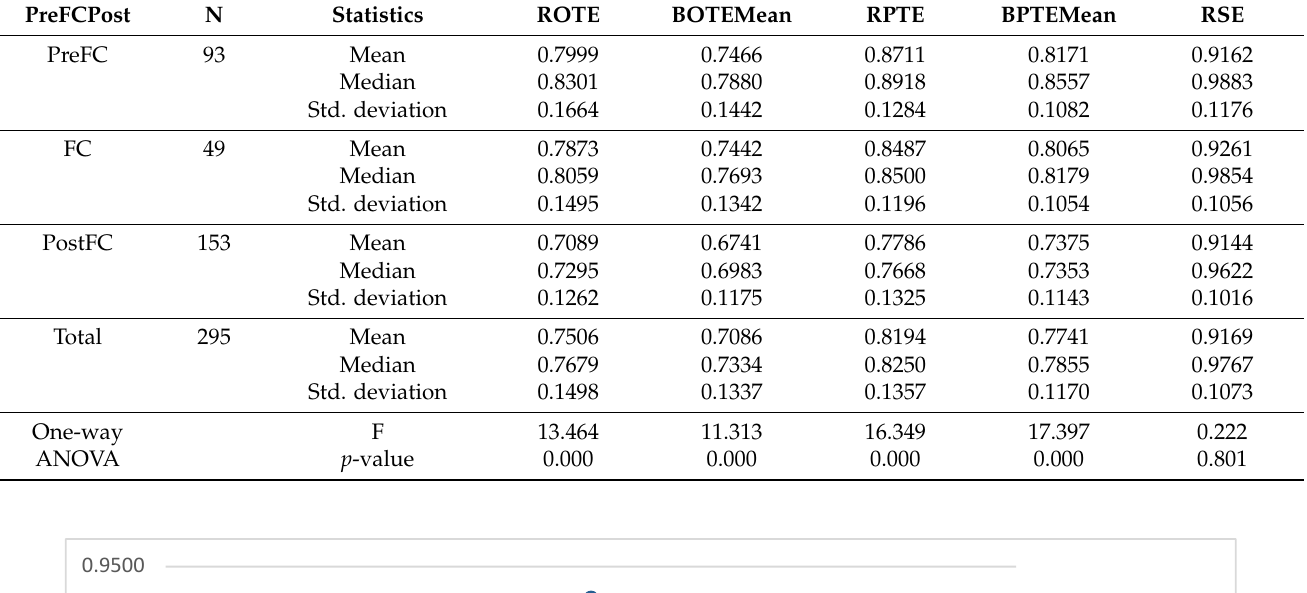
Table 6. Results of the ANOVA test: comparison of the efficiencies of the power-generating companies during the financial crisis period.